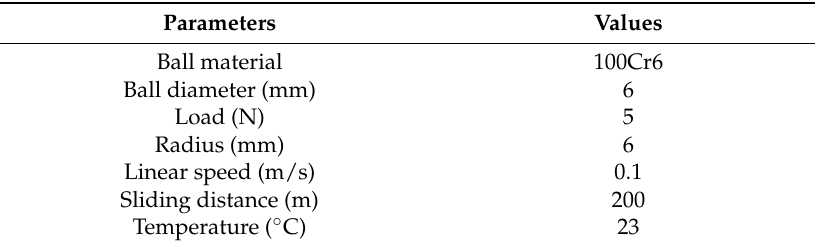
Table 3. Wear tests conditions (ball-on-disk tests).